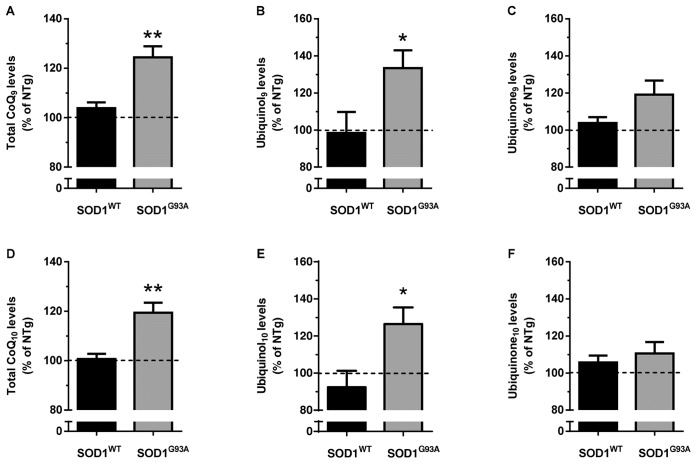
Increased levels of ubiquinol9/10 in the brain of symptomatic SOD1G93A mice.Endogenous brain levels of CoQ9 (A–C) and CoQ10 (D–F) in 16 week-old male 129Sv SOD1WT and SOD1G93A mice are shown as percentage of the levels measured in age-matched 129Sv non-transgenic mice (absolute values in table S1). Panels A, D show the total CoQs levels, whereas panels B, E and panels C, F show the reduced and oxidized forms, respectively. Each value is the mean±SEM of 4–7 mice. * P<0.05, ** P<0.01 compared to SOD1WT mice (Student’s T-test).